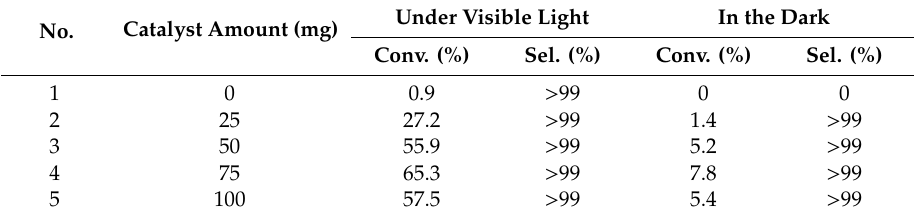
Table 3. E ff ect of di ff erent amounts of catalyst on the reaction of benzyl alcohol and acetophenone. Under Visible Light In the Dark No. Catalyst Amount (mg) Conv. (%) Sel. (%) Conv. (%)